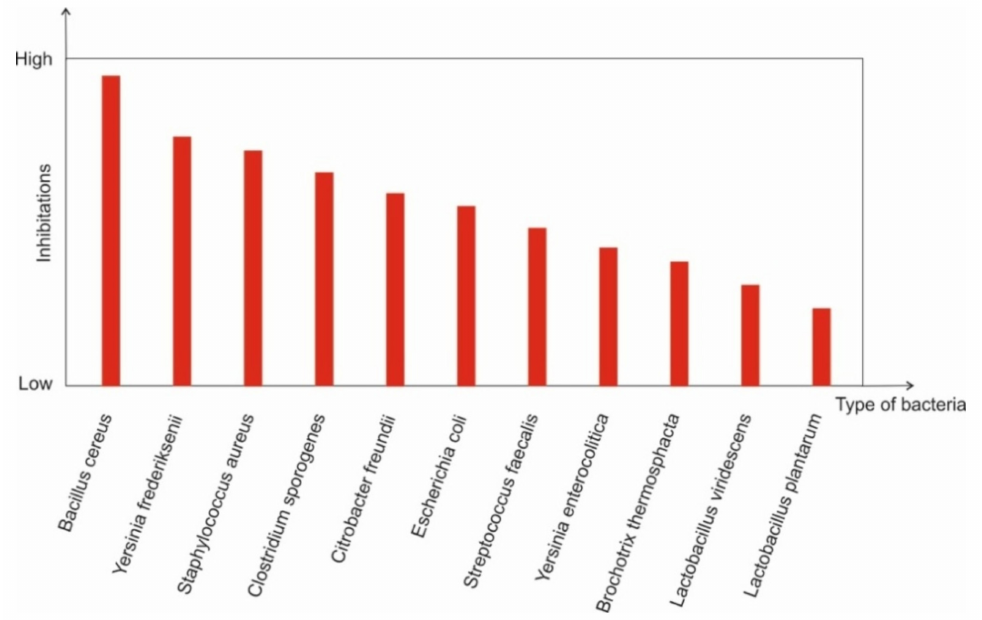
Figure 6. The influence of CO 2 on various bacteria, reprinted with permission from WITT